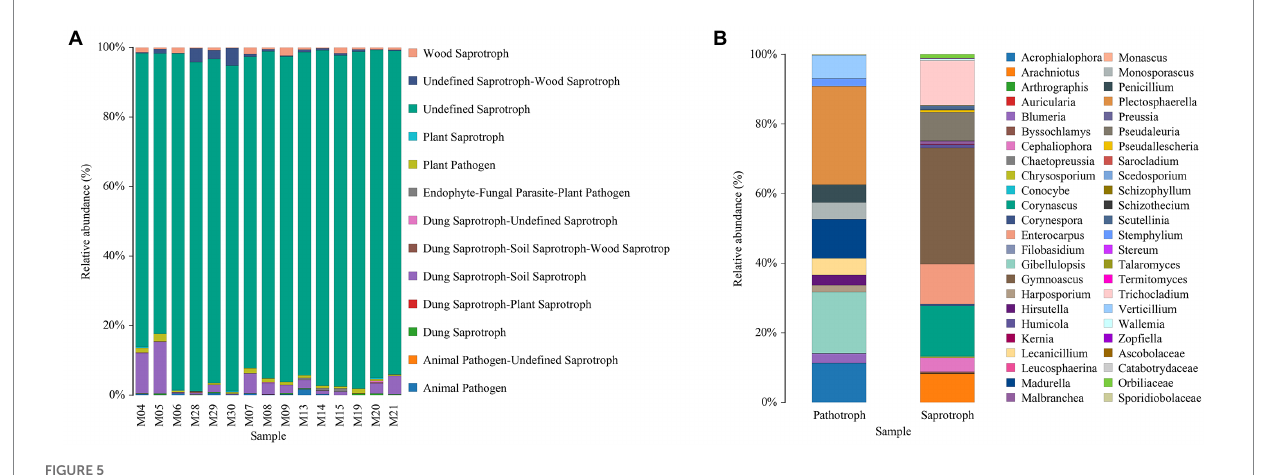
FIGURE 5 Fungal types in different treatments (A) and the distribution of specific genus (B)